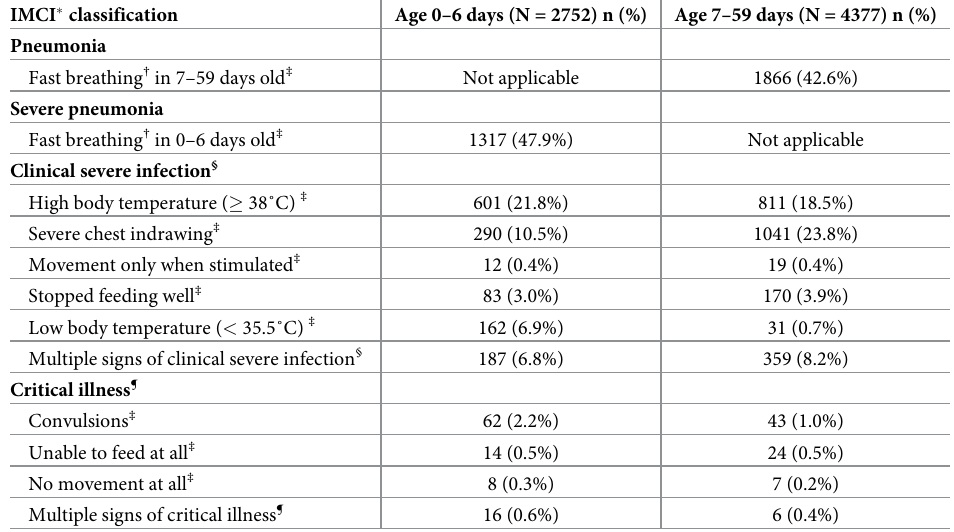
Table 1. Distribution of signs of IMCI � classification stratified by age categories in young infants presenting with any sign of possible serious infection (n = 7129). IMCI �